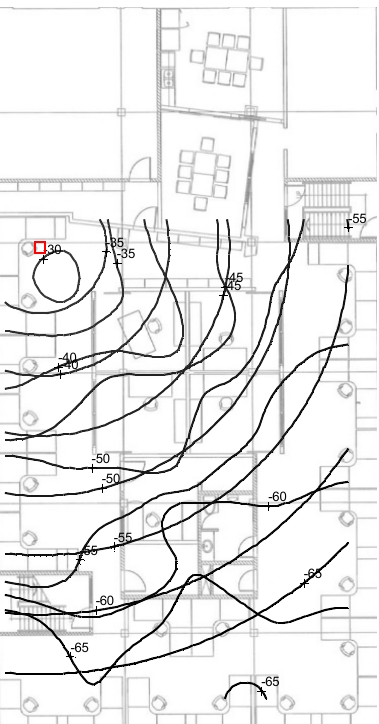
Figure 15. Superposition of the parametric RSS model (concentric circles) and the non-parametric RM with red square the estimated position of the AP at 2.4 GHz.